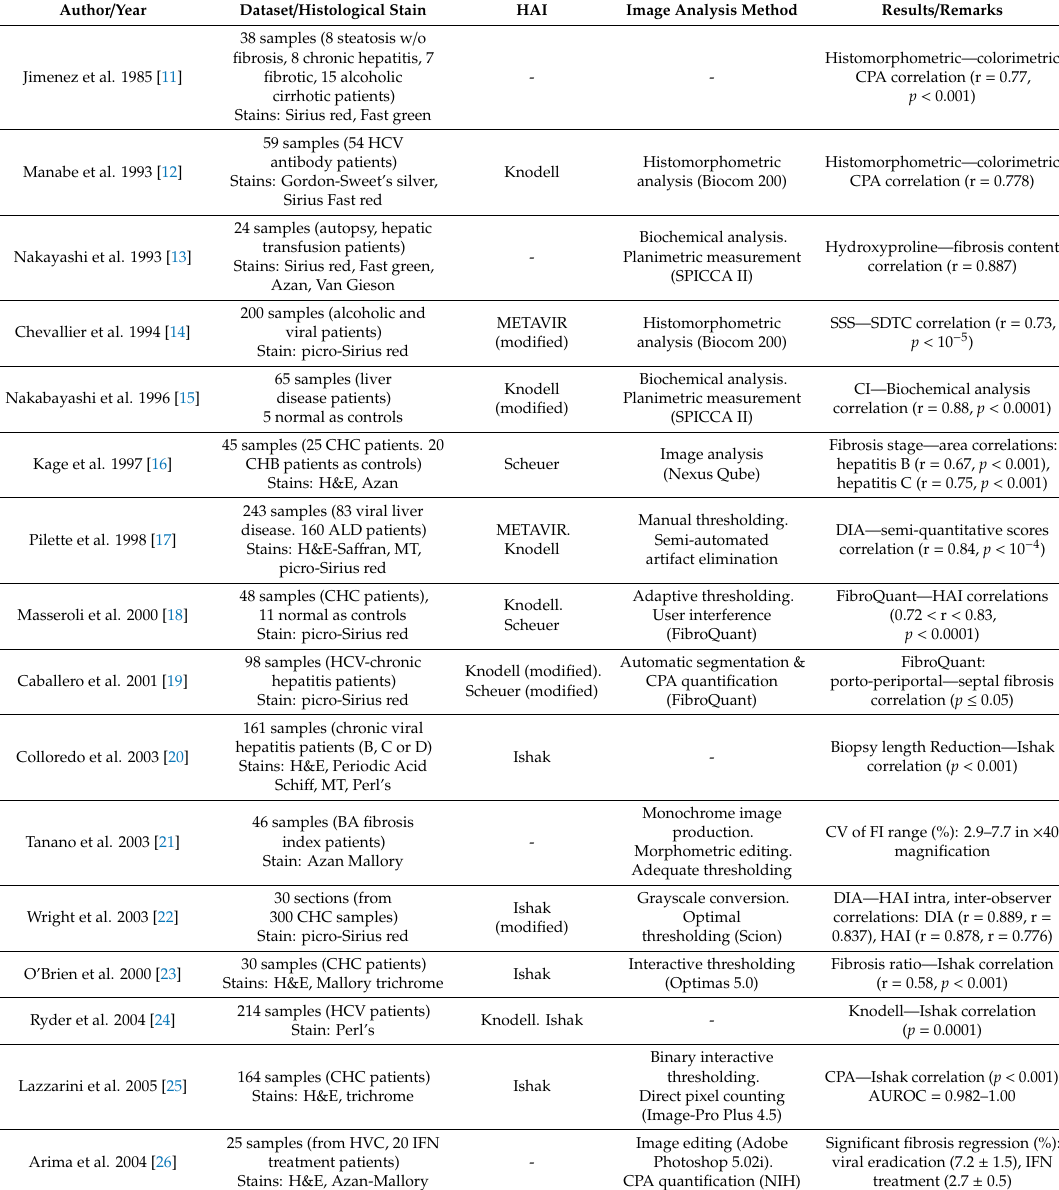
Table 2. Comparison of works using exclusively semi-quantitative examinations for collagen proportionate area (CPA) calculation and combinatorial systems employing digital image analysis (DIA) with histology activity index (HAI) performance